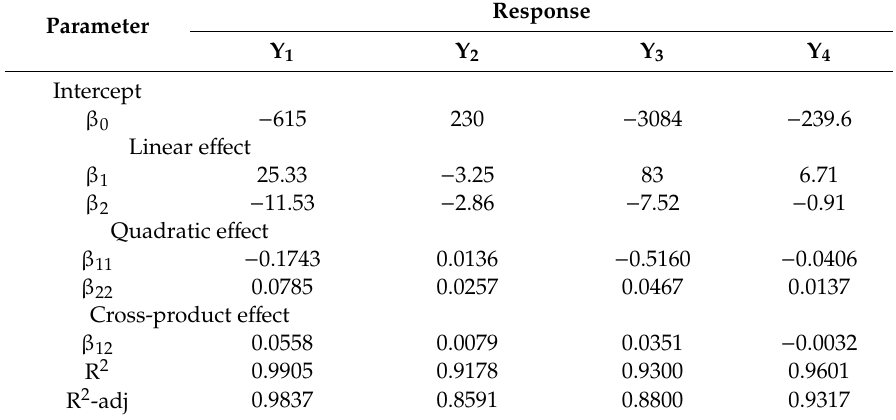
Parametric results of the second-order polynomial equation of Equation (2) for ultrasound-assisted extraction (UAE) of antioxidants from ginger for the four responses, Y 1 , Y 2 , Y 3 , and Y 4 and fitting coe ffi cients obtained after applying the central composite rotatable